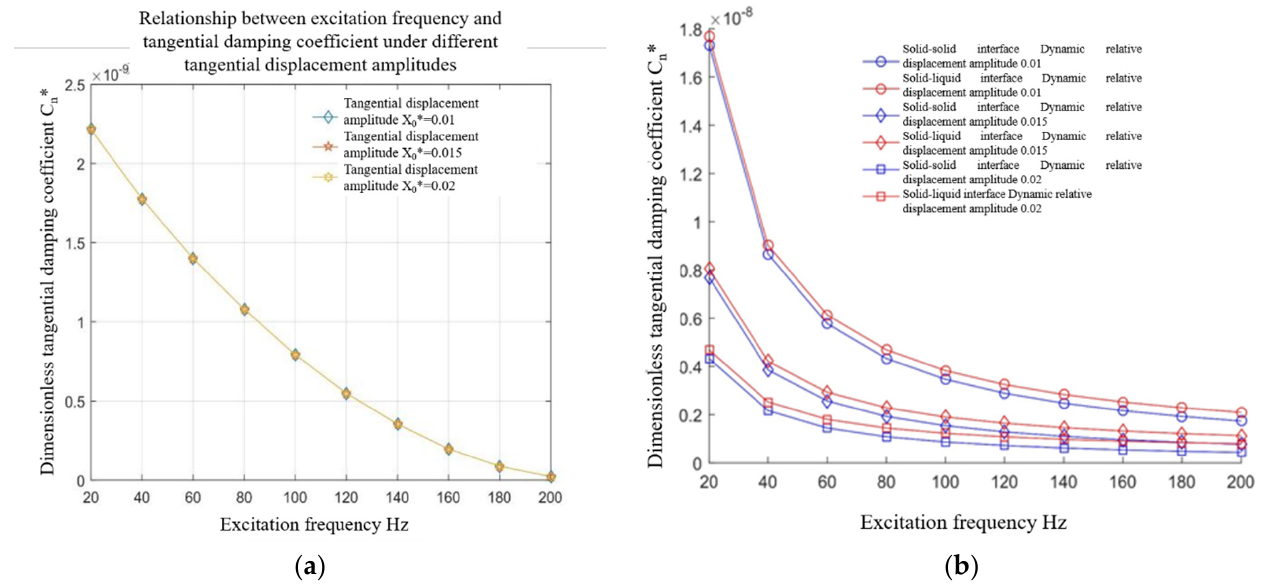
Figure 9. Relationship between the excitation frequency and the tangential damping coefficient of the solid–solid and solid–liquid interfaces under different tangential displacement amplitudes. ( a ) Fluid contact characteristics, ( b ) solid–solid and solid–liquid bonding face ratio.